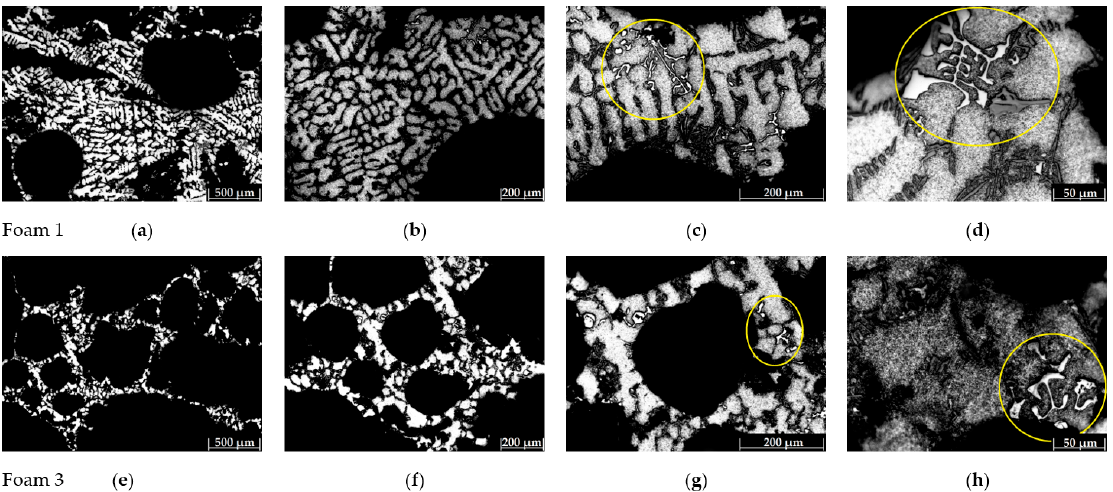
Figure 8. Representative optical microphotographs of the central region of the A356 aluminum alloy foams manufactured of ( a ) Foam 1, ( b ) Foam 2, ( c ) Foam 3, and ( d ) Foam 4. Figure 9 shows the foam microstructures obtained using optical microscopy to dif ‐ ferent magnifications for foams 1 and 3, refined and modified and without the melt treat ‐ ment, respectively.